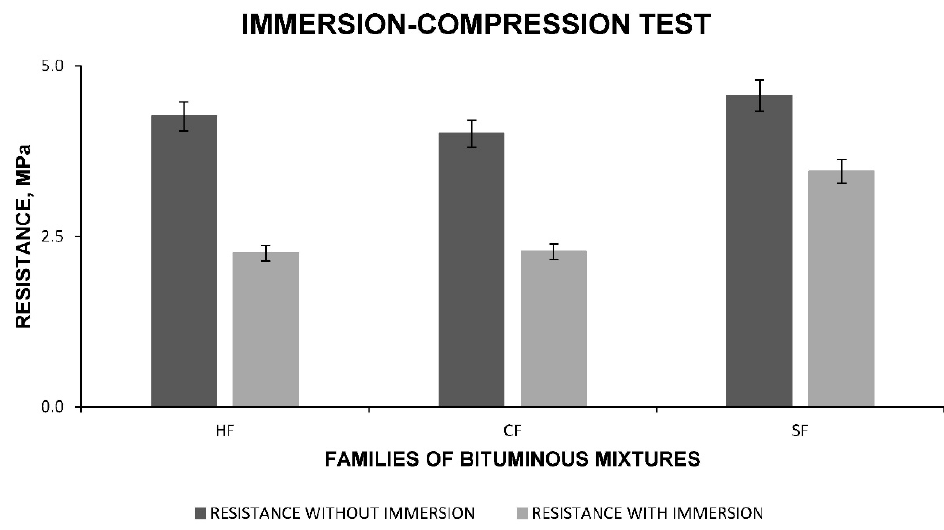
Figure 10. Immersion–compression test for the optimum combination of materials from the HF, CF and SF bituminous mix families.